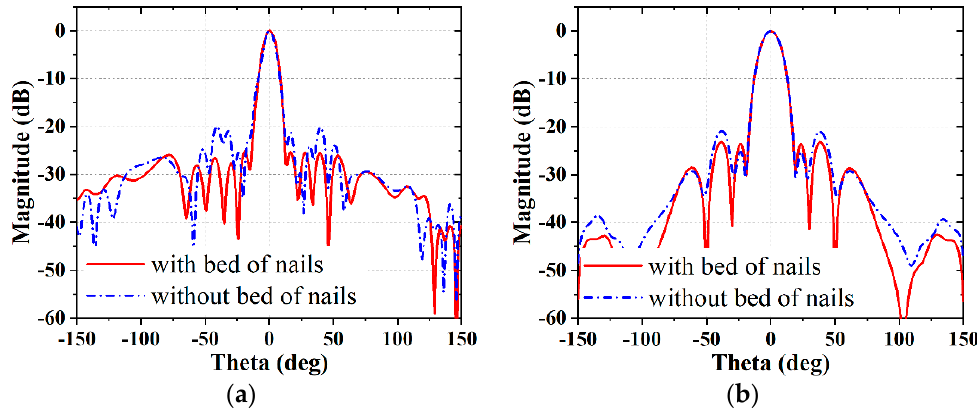
Figure 12. The full-wave extracted magnitude of the electric field in a plane above the GCPW feeding network. ( a ) Without the bed of nails. ( b ) With the bed of nails.